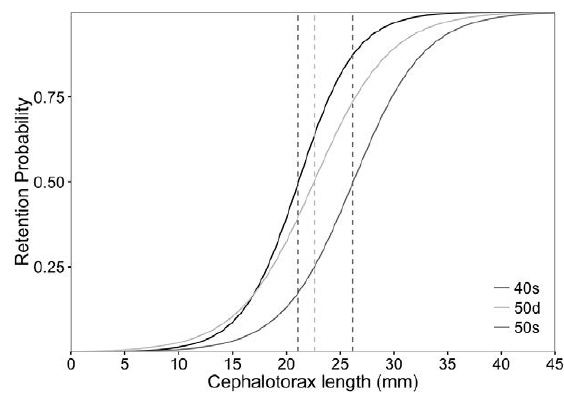
Fig. 5. – Mean selectivity curves for the 50-mm diamond mesh (50d), 40-mm square mesh (40s) and 50-mm square mesh (50s), obtained taking into account between-haul variability. The verti- cal dashed lines indicate the L for the three mesh configurations 50 (black, 40s; light grey, 50d; dark grey,